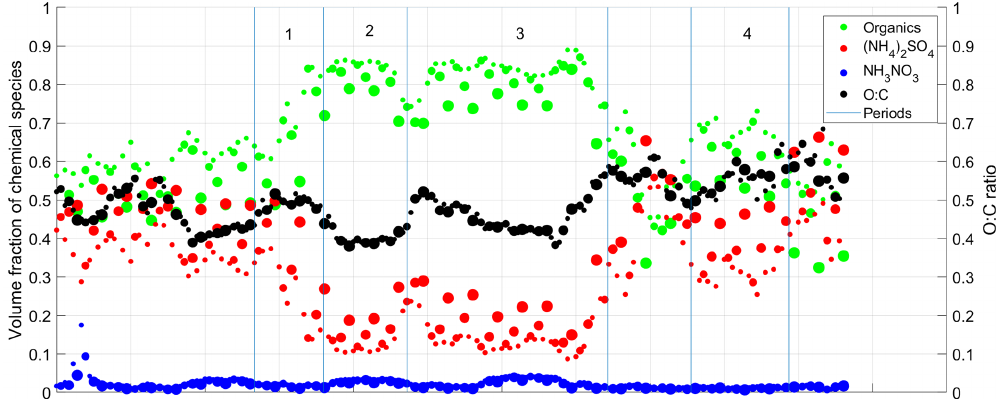
Figure 4. Time series of the volume fractions of organics, (NH 4 ) 2 SO 4 , and NH 4 NO 3 observed at the BNL site from 10 to 15 August 2012. Note that the increase of the symbol size represents the TD temperature increase from the ambient temperature to 100 ◦ C. The green dot represents the organic species. The red dot represents ammonium sulfate. The blue dot represents ammonium nitrate. The black dot represents the O : C ratio. Periods 1, 2, 3 were influenced by the air mass from LRNW, and period 4 was dominated by SSW air mass.